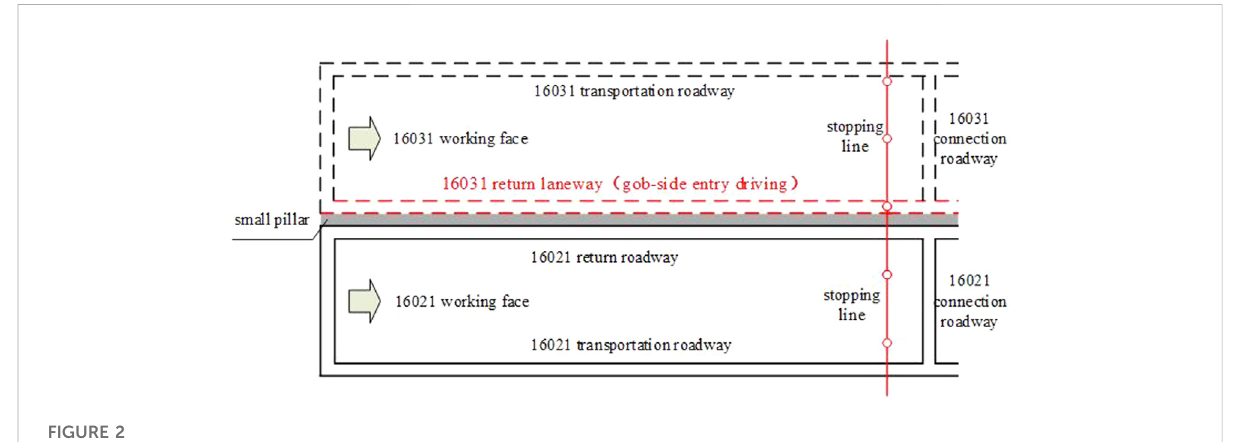
FIGURE 2 16021 working face